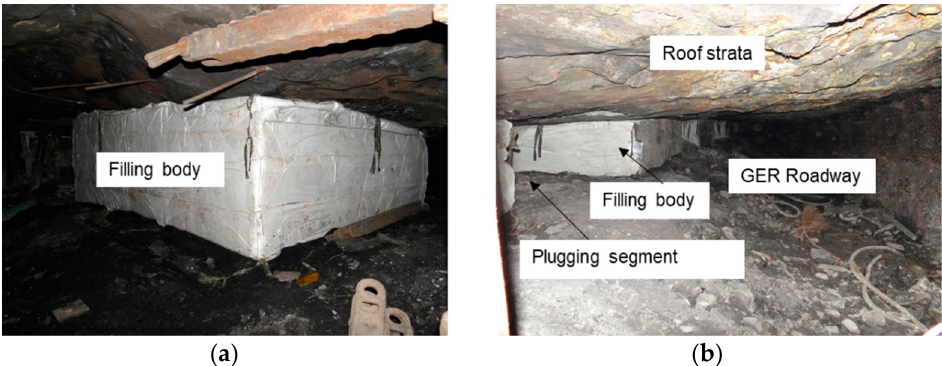
Figure 14. On-site roadside filling body. ( a ) Filling body diagram in Roadway( b ) Forming roadway with filling body. with filling